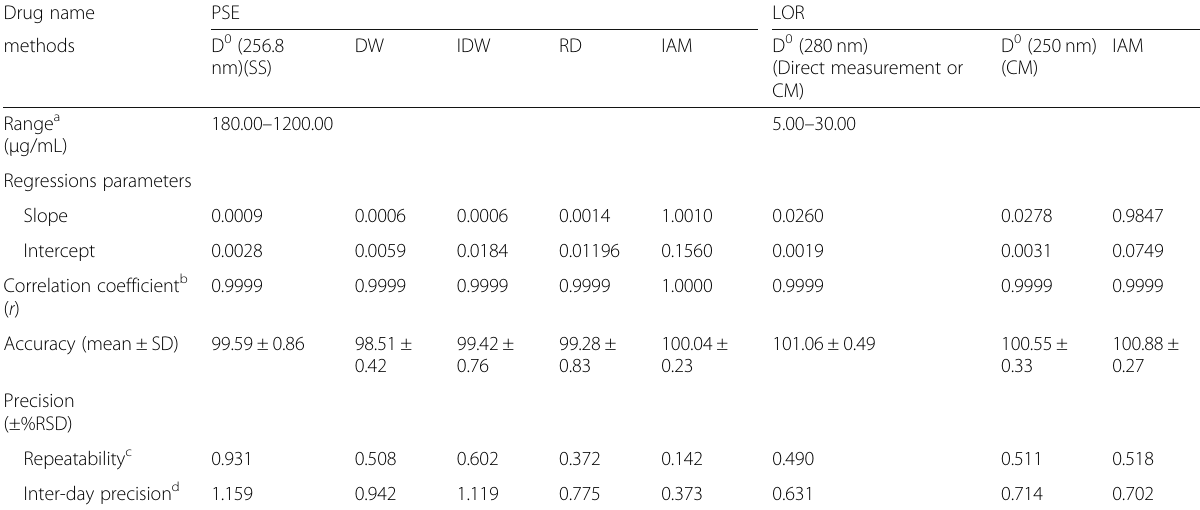
Table 1 Regression parameters and the results of determination of pure samples of PSE and LOR by the proposed methods Drug name PSE